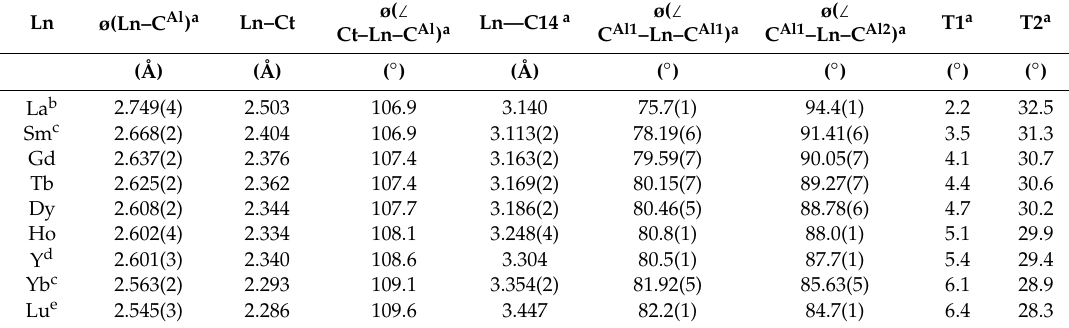
Table 1. Comparison of the crystal structures of the Cp* rare-earth-metal bis(tetramethylaluminate) species 1 Ln